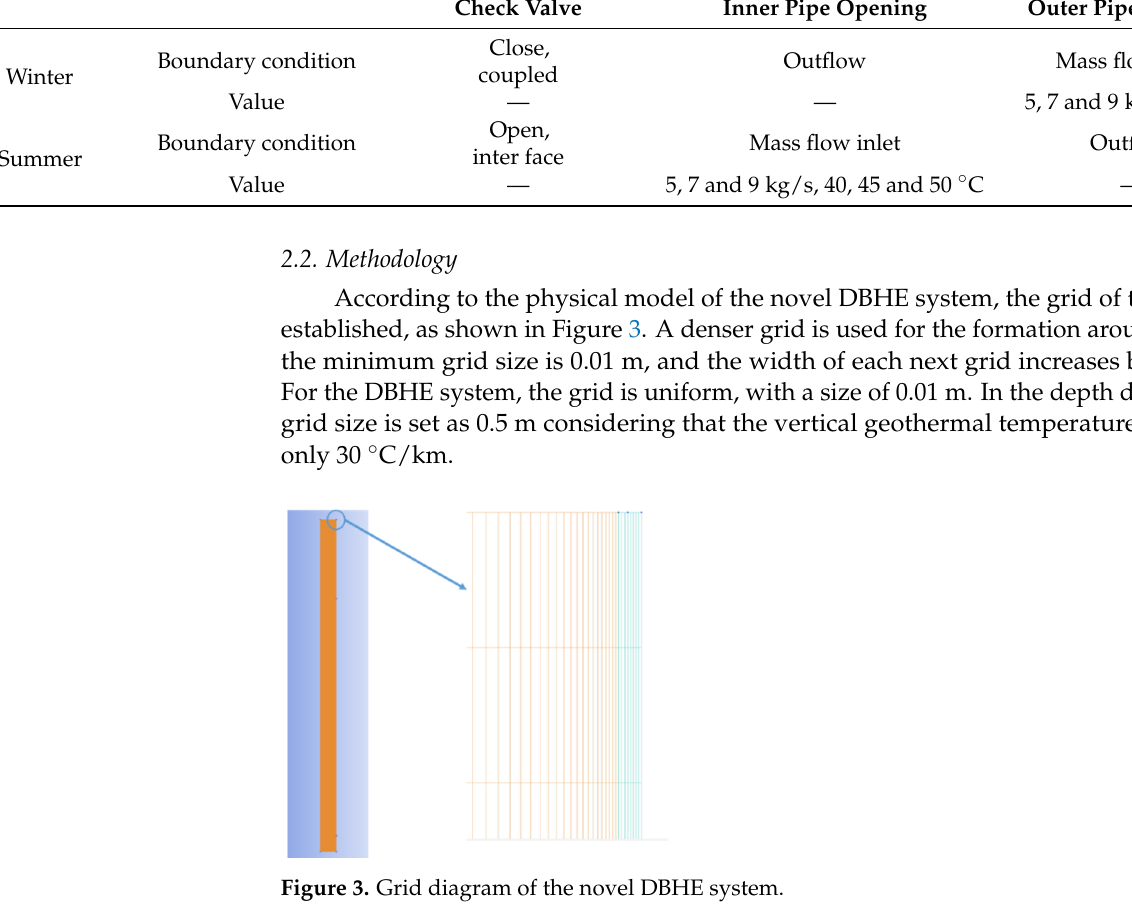
Figure 3. Grid diagram of the novel DBHE system.